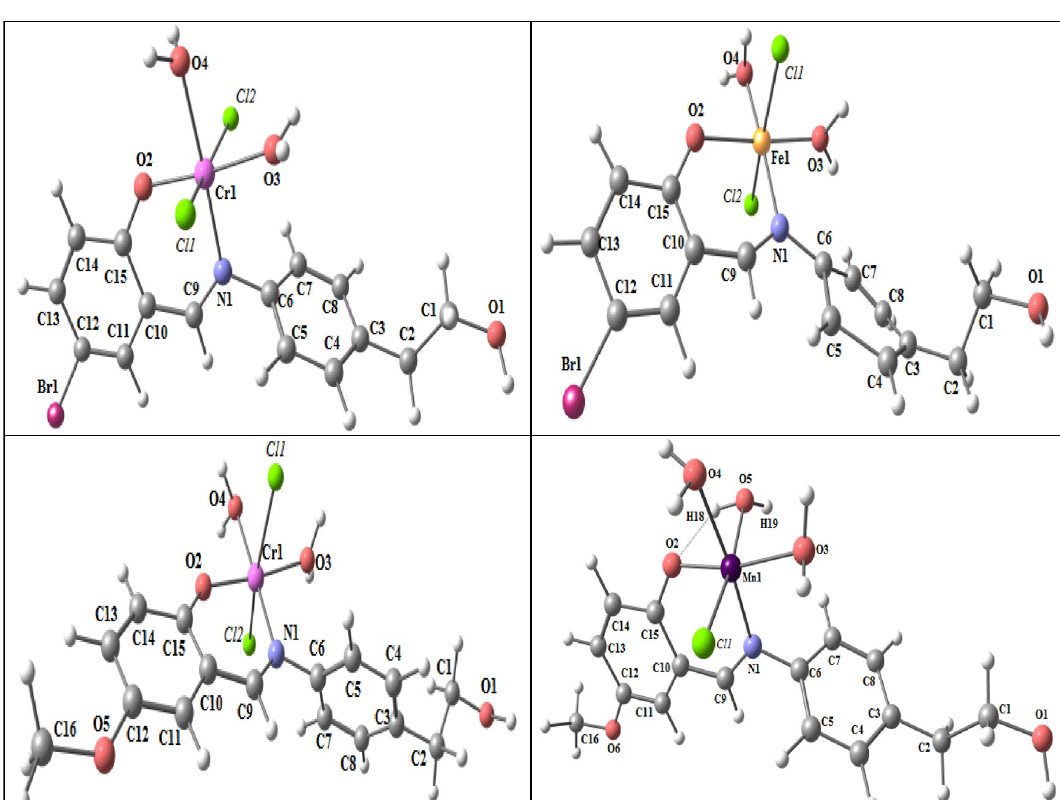
Figure 6. The optimized structures of [Fe(L1)(H 2 O) 2 Cl 2 ] ( a ), [Cr(L1)(H 2 O) 2 Cl 2 ], up, and [Cr(L2)(H 2 O) 2 Cl 2 ] down ( b ) and of [Mn(L2)(H 2 O) 3 Cl ] ( c